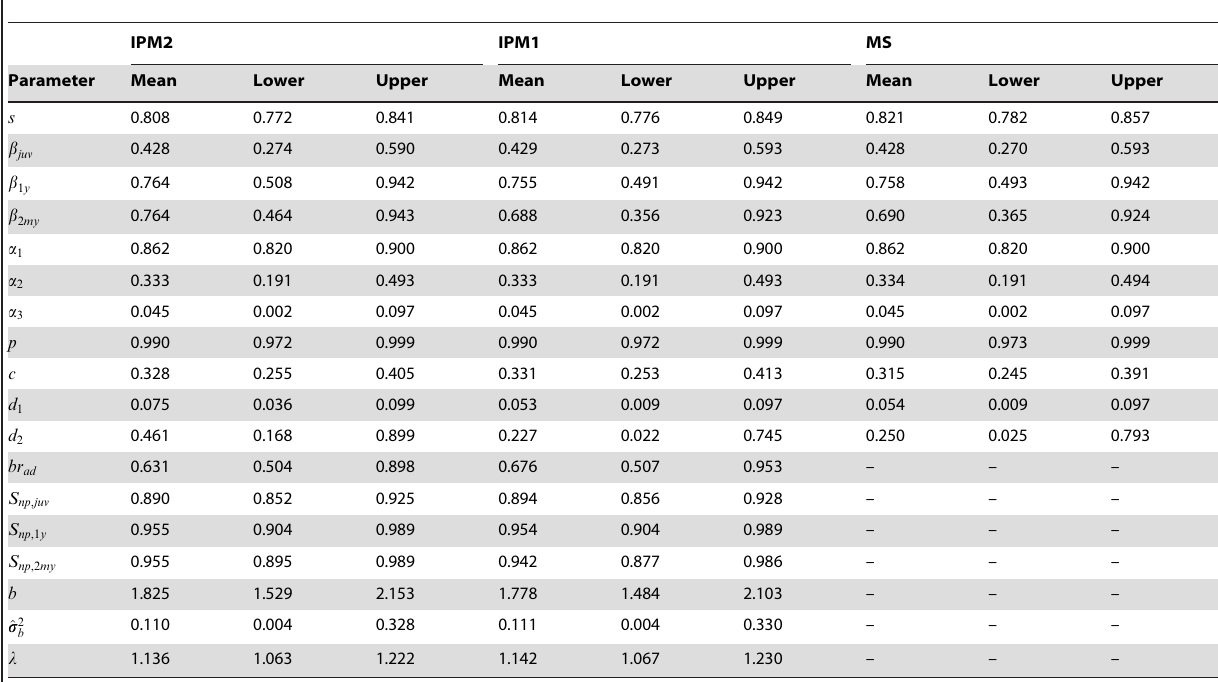
Table 1. Estimated demographic parameters of the Red kite population of the island of Mallorca (Spain).